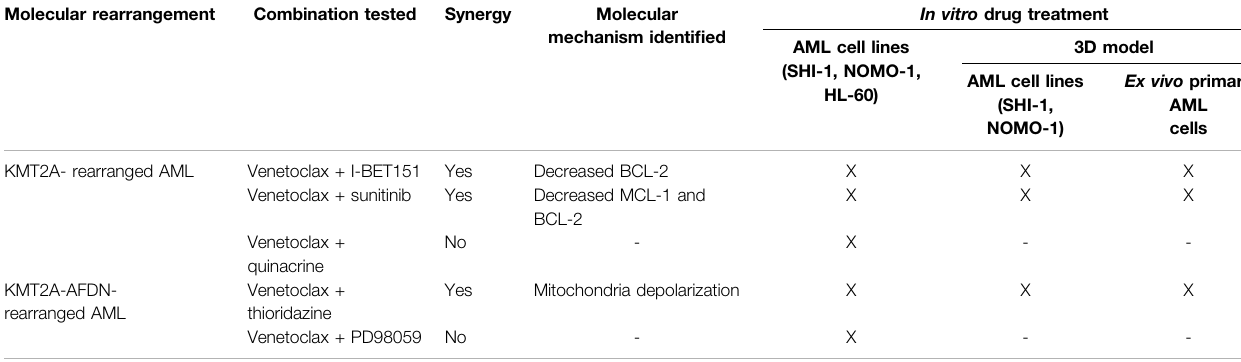
TABLE 1 | List of the combinations tested, the molecular mechanisms identi fi ed for the observed synergy, and the setting where the treatments were performed. Molecular